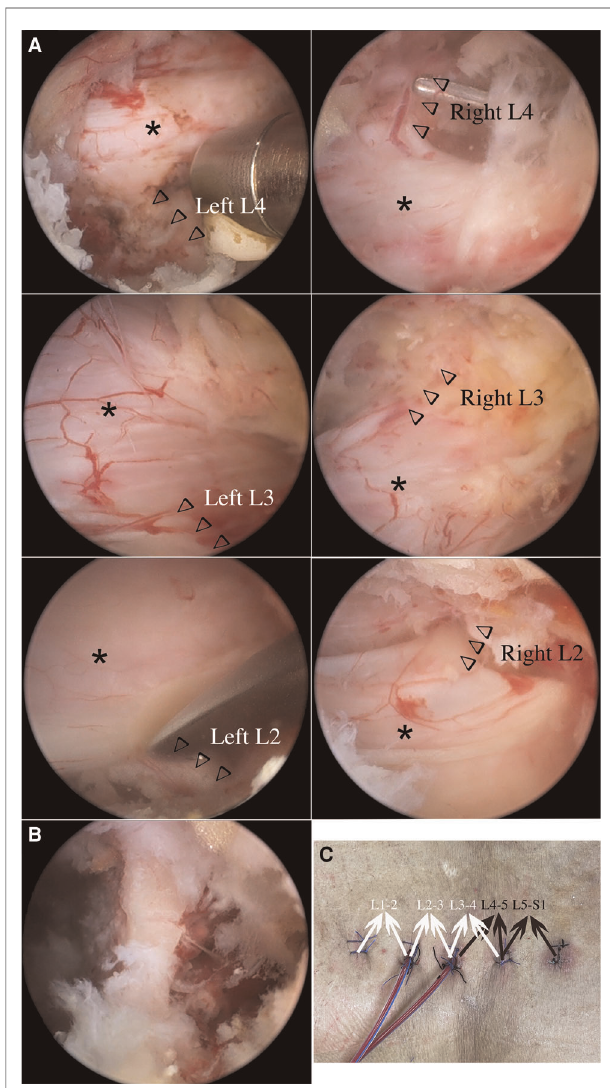
FIGURE 3 | Bilateral L4, L3 and L2 nerve roots and dural sacs after second- stage UBE-ULBD (arrowheads indicate nerve roots, asterisks indicate dural sacs) ( A ). Residual left lamina of L4 after L4-5 and L3-4 UBE-ULBD ( B ). The surgical incisions after the two-stage procedure and the counterparts of the surgical segments (black arrowheads indicate the fi rst-stage operation, white arrowheads indicate the second-stage operation) ( C